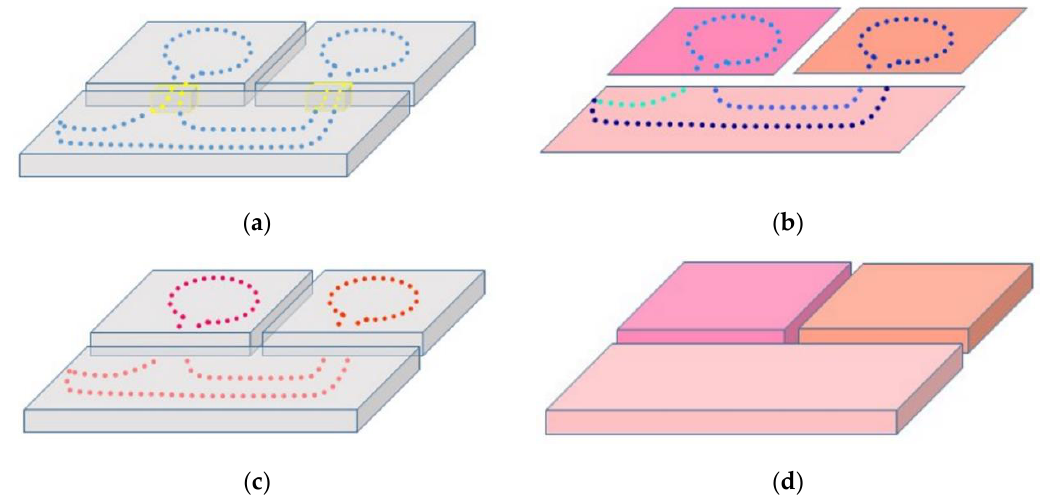
Figure 3. Room segmentation process. ( a ) Raw point cloud (grey) and trajectory classified as door (yellow) and nondoor positions (blue). ( b ) Clustered room regions and projected trajectory segments. ( c ) Labeled trajectory and unlabeled point cloud (grey). ( d ) Segmented point cloud from labeled trajectory positions.